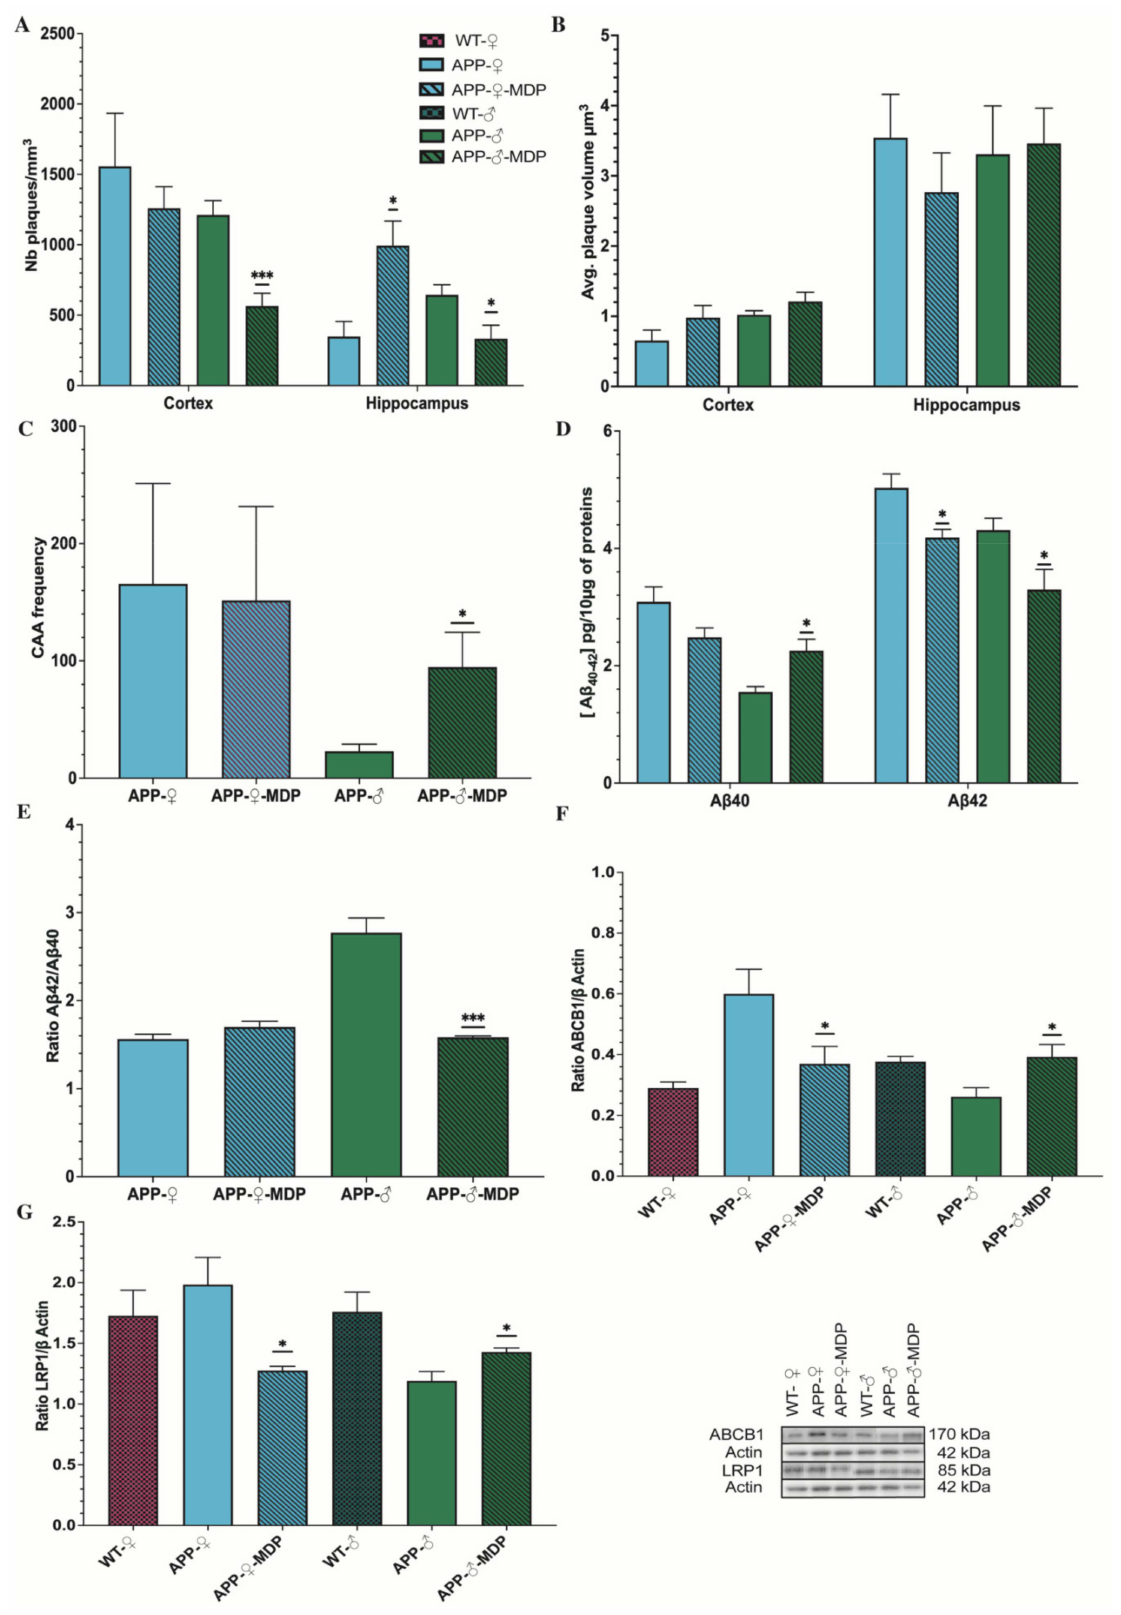
Figure 4. The long-term administration of MDP has a different effect on amyloid regarding the sex. Although, MDP induces an increase in the plaque number in the female APP Swe /PS1 treatment with MDP group. ( A ): Unbiased stereological analysis of the 6E10 + plaque number of the male and